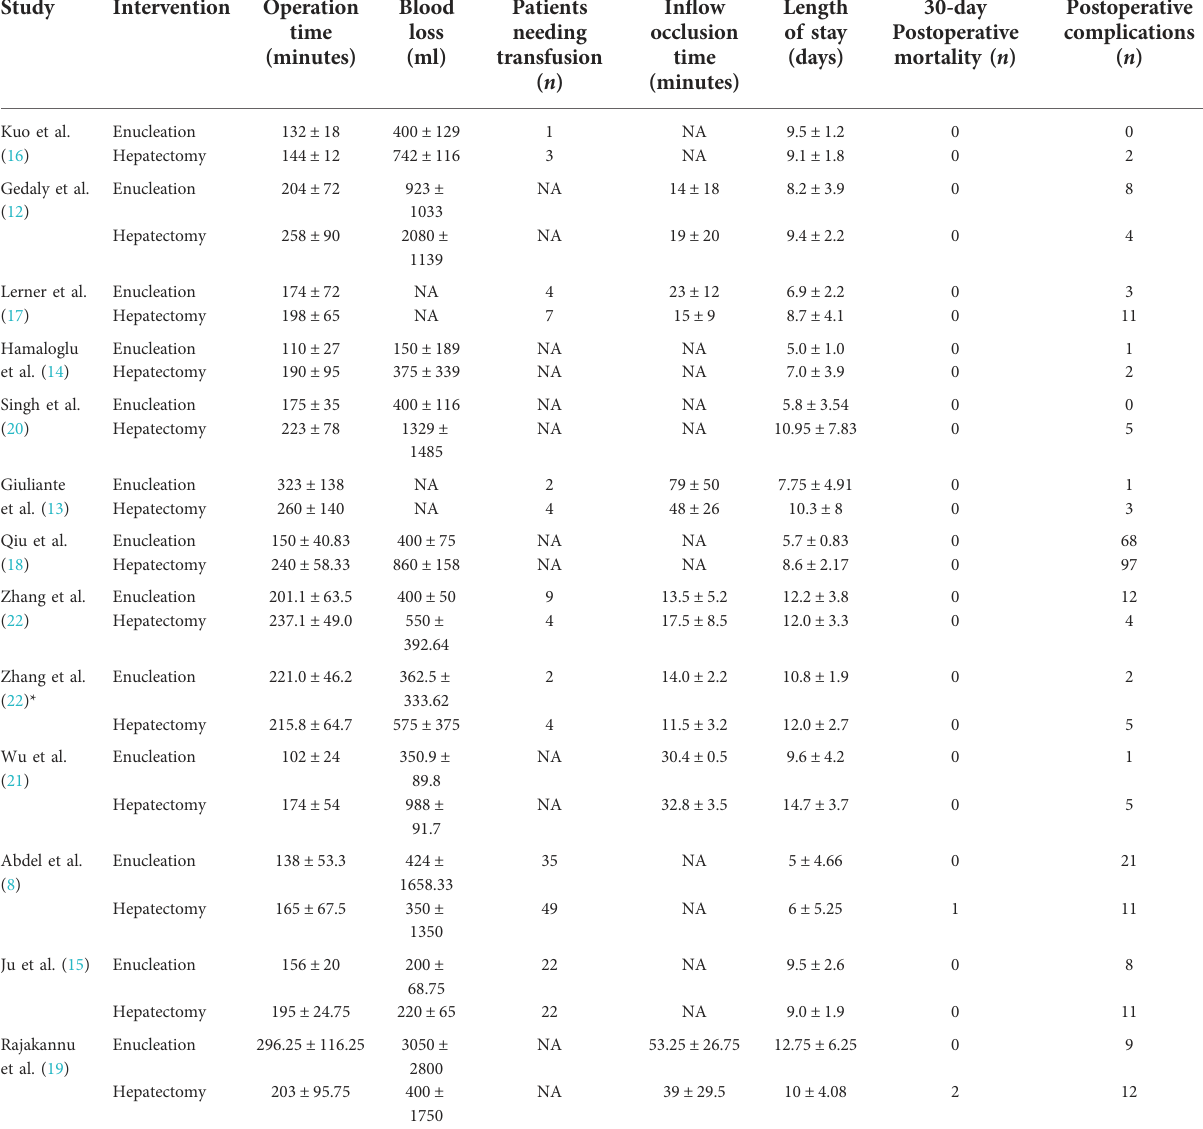
TABLE 3 The outcomes following enucleation or hepatectomy in patients with hepatic hemangiomas.